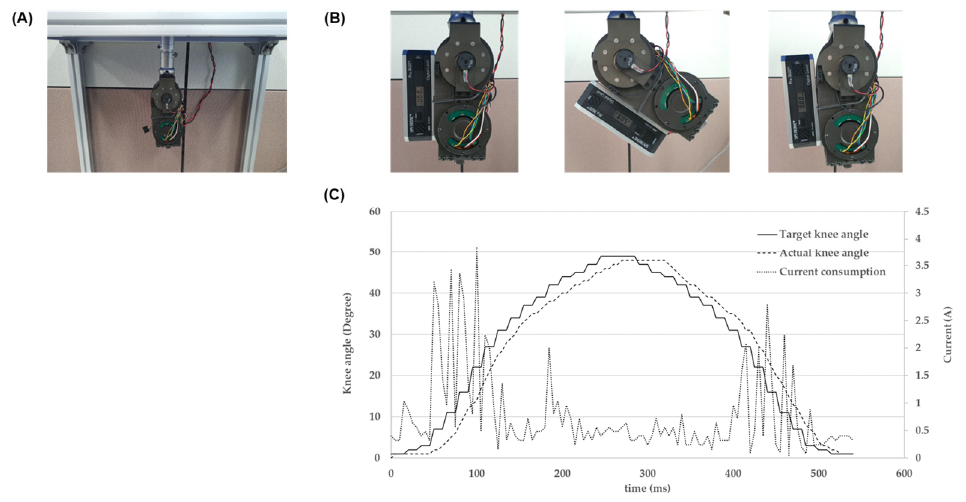
Figure 11. ( A ) Measurement test environment for gait speed during swing phase; ( B ) the movement of the prosthesis during swing phase (0° -> 60° -> 0°); ( C ) an actual knee angle and current consumption according to the command input during the swing phase in the automatic mode.